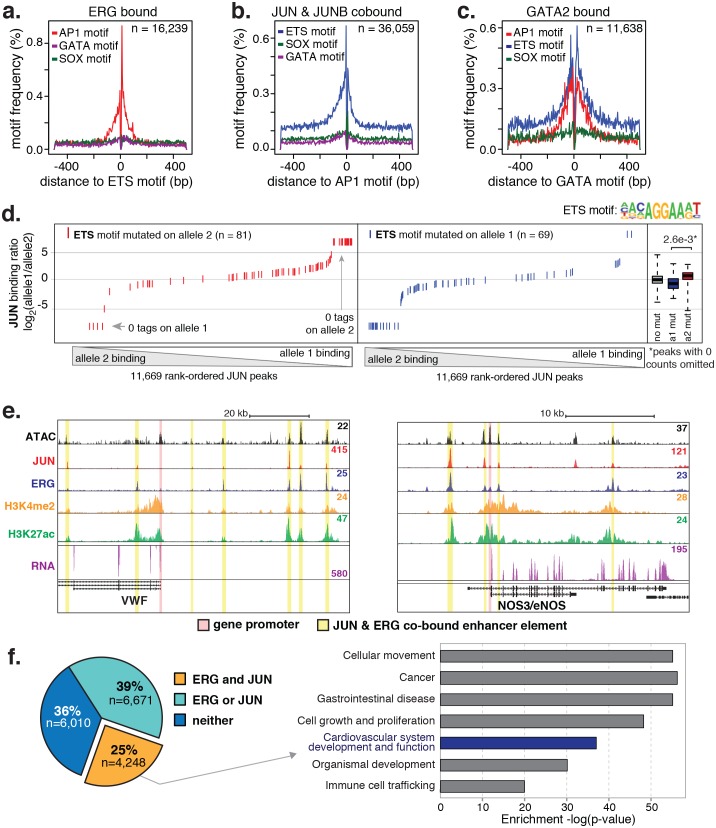
ERG and JUN co-bind EC enhancers and are enriched at EC-specific genes.(a–c) Promoter-distal regions bound by ERG, JUN, and JUNB, or GATA2 are shown in a, b, and c respectively in a one kilobase window. Each set was centered on the corresponding binding motif, and the frequency of other enriched motifs are shown on the y-axis. GATA2 binding was measured in HUVECs. (d) Allele-specific JUN binding (y-axis) as a function of allele-specific ETS motif mutations (colored lines). Each vertical line represents a single JUN peak identified via ChIP-seq. For a more complete explaination see the Figure 3—figure supplement 1 legend and methods section. (e) TF binding for JUN and ERG, the histone modifications H3K4me2 and H3K27ac and RNA abundance are shown at the genetic loci for VWF and NOS3. Promoters are highlighted in pink and JUN/ERG co-bound enhancers are highlighted in yellow. (f) The HAEC enhancer set from Figure 1a is annotated for JUN and/or ERG binding. Ingenuity Pathway Analysis results are shown for the genes nearest the 4248 JUN/ERG co-bound enhancers in the right panel. More related data in Figure 3—figure supplements 1 and 2.